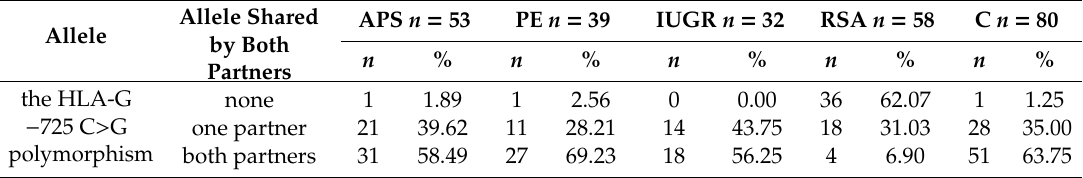
Table 4. The frequency of the alleles of the − 725 C > G polymorphism in the HLA-G promoter region shared by both parents in the pairs with pregnancies complicated by antiphospholipid syndrome (APS), preeclampsia (PE), intrauterine growth restriction (IUGR), recurrent spontaneous abortion (RSA), and the control group. Results are from chi-square